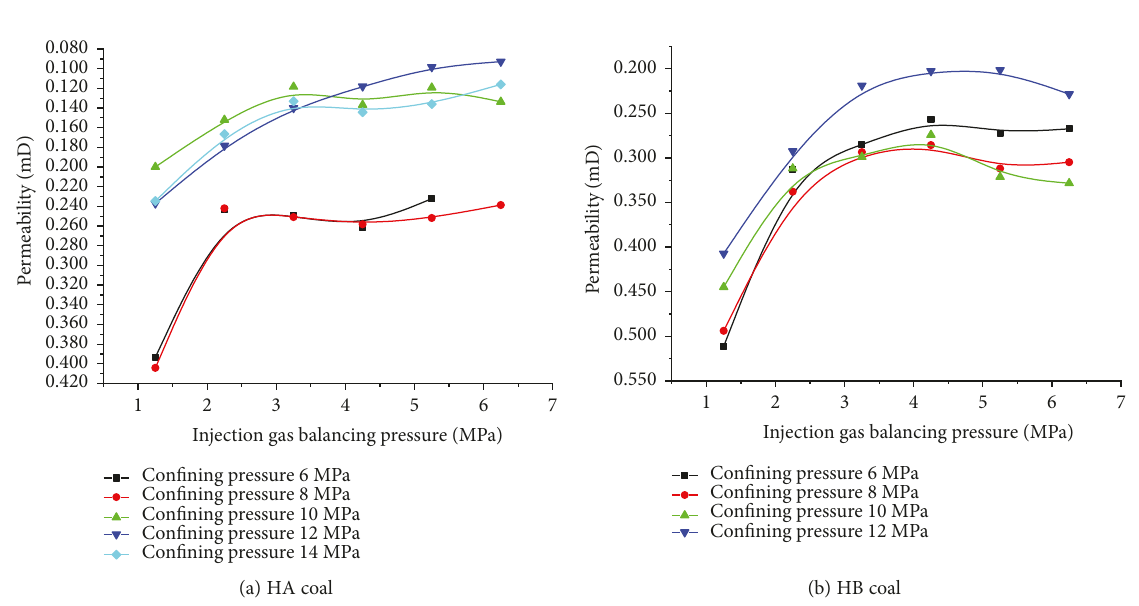
Figure 6: Permeability change characteristics due to gas desorption under di ff erent con fi ning